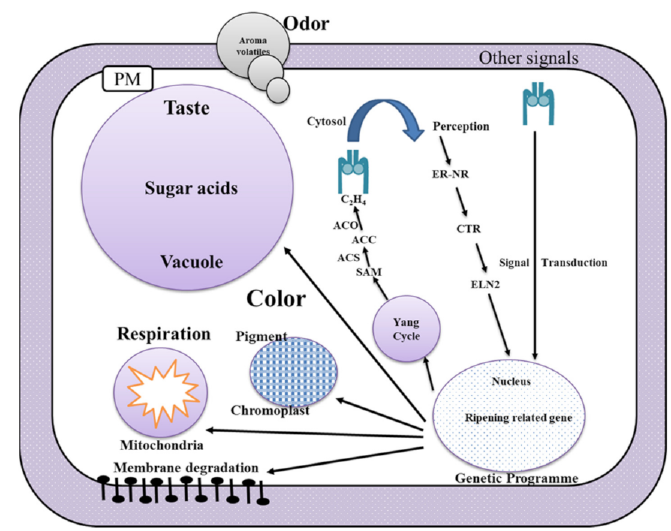
Figure 1. Mechanism of fruit ripening (modified from Bouzayen et al.